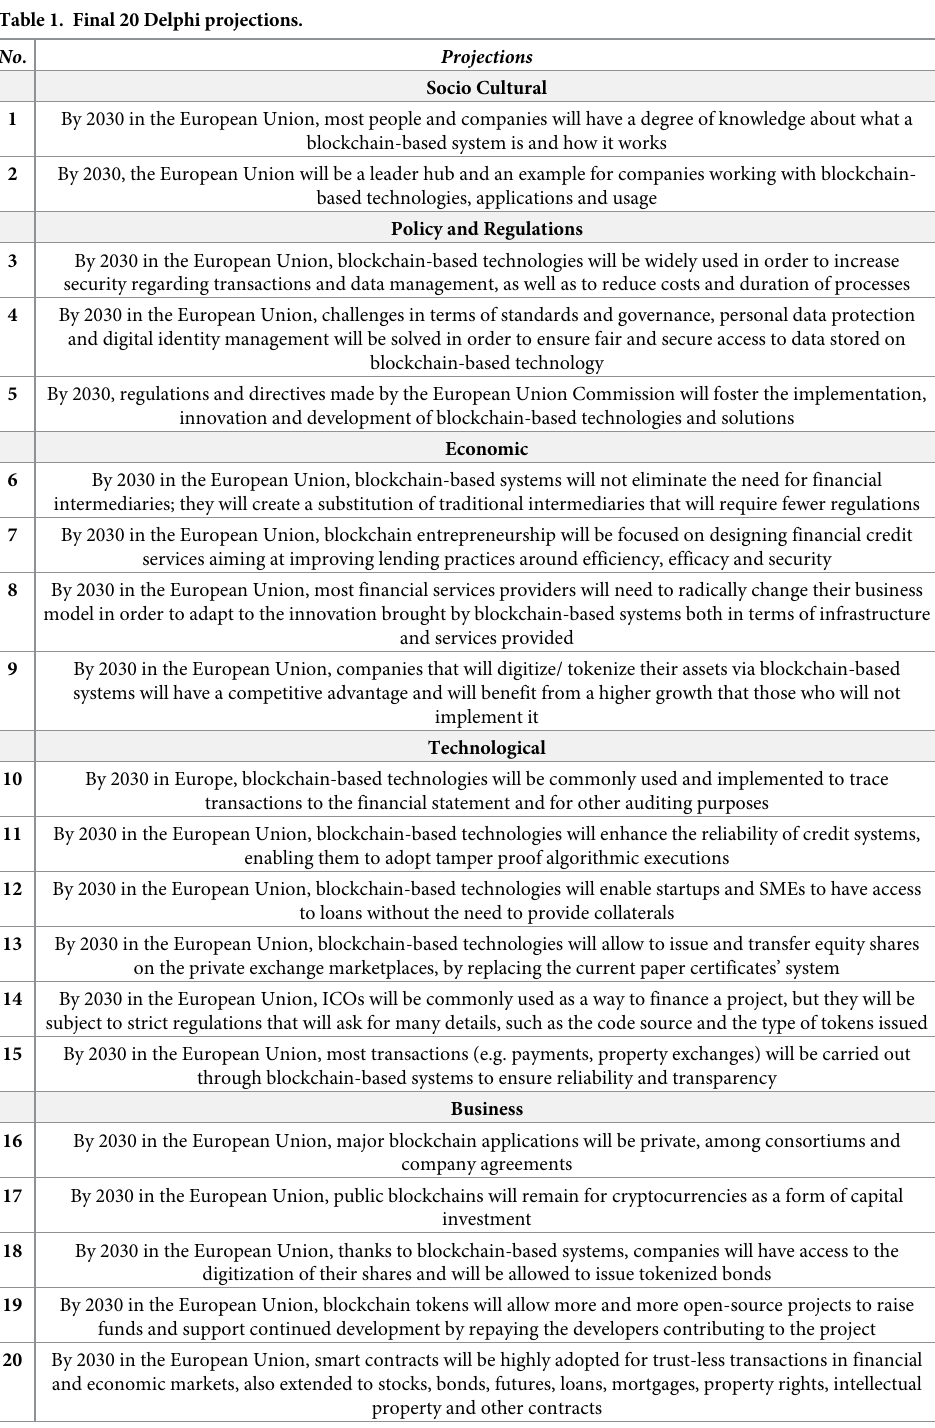
Table 1. Final 20 Delphi